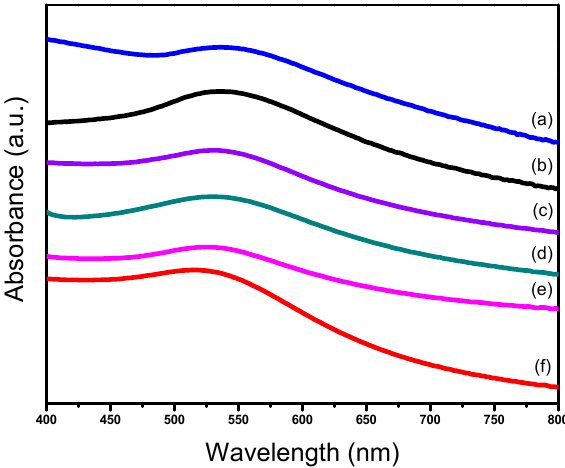
Figure 3. UV-vis spectra of di ff erent supported gold catalysts; ( a ) Au 25 / SiO 2 -300; ( b ) Au 25 / MgAl-300; ( c ) Au 25 / MgO-300; ( d ) Au 25 / ZnAl-300; ( e ) Au 25 / ZnO-300; ( f ) Au 25 / Al 2 O 3 -300.